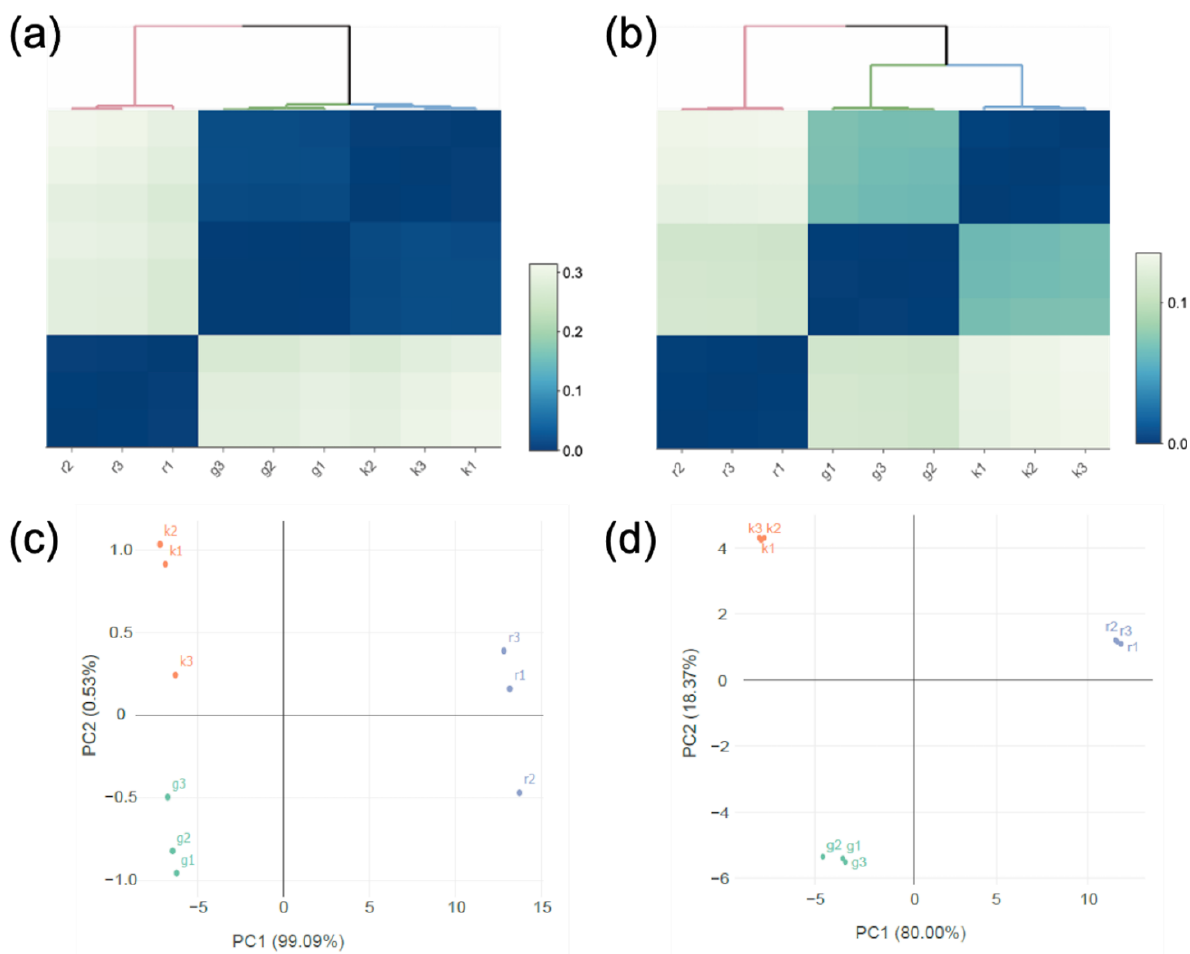
Figure 4. Hierarchical clustering ( a ) and ( b ) and Principal component analysis (PCA, c and d ) based on transcriptome analysis of L. gasseri JCM 1131 T ( a ) and ( c ) and L. paragasseri JCM 11657 ( b and d ) in cultures with glucose (denoted by g), kestose (denoted by k), or raffinose (denoted by r). The transcriptome analysis was performed in triplicate using RNA isolated from three different cultures for each carbohydrate.